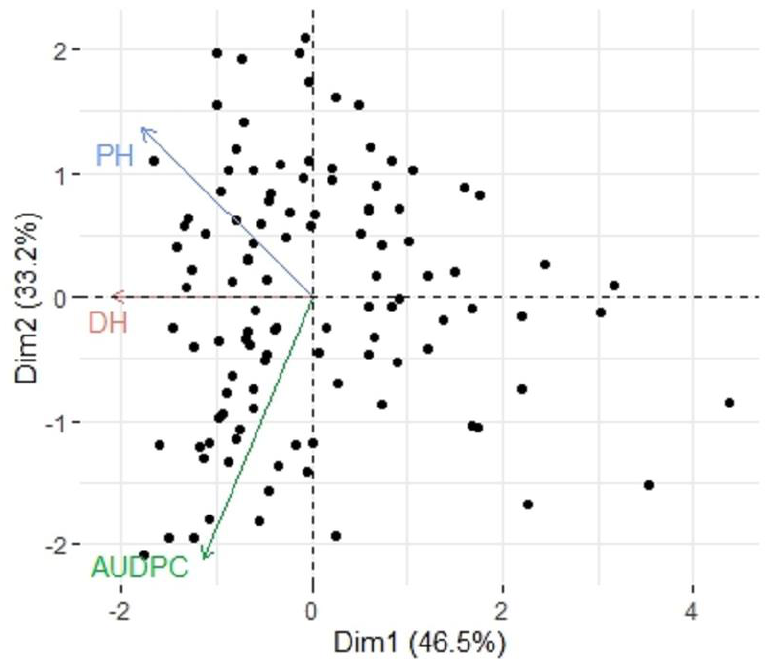
Figure 6. Principal component analysis (PCA) representing the contribution of three factors: plant height (PH), days to heading (DH) and AUDPC scores in 113 accessions.